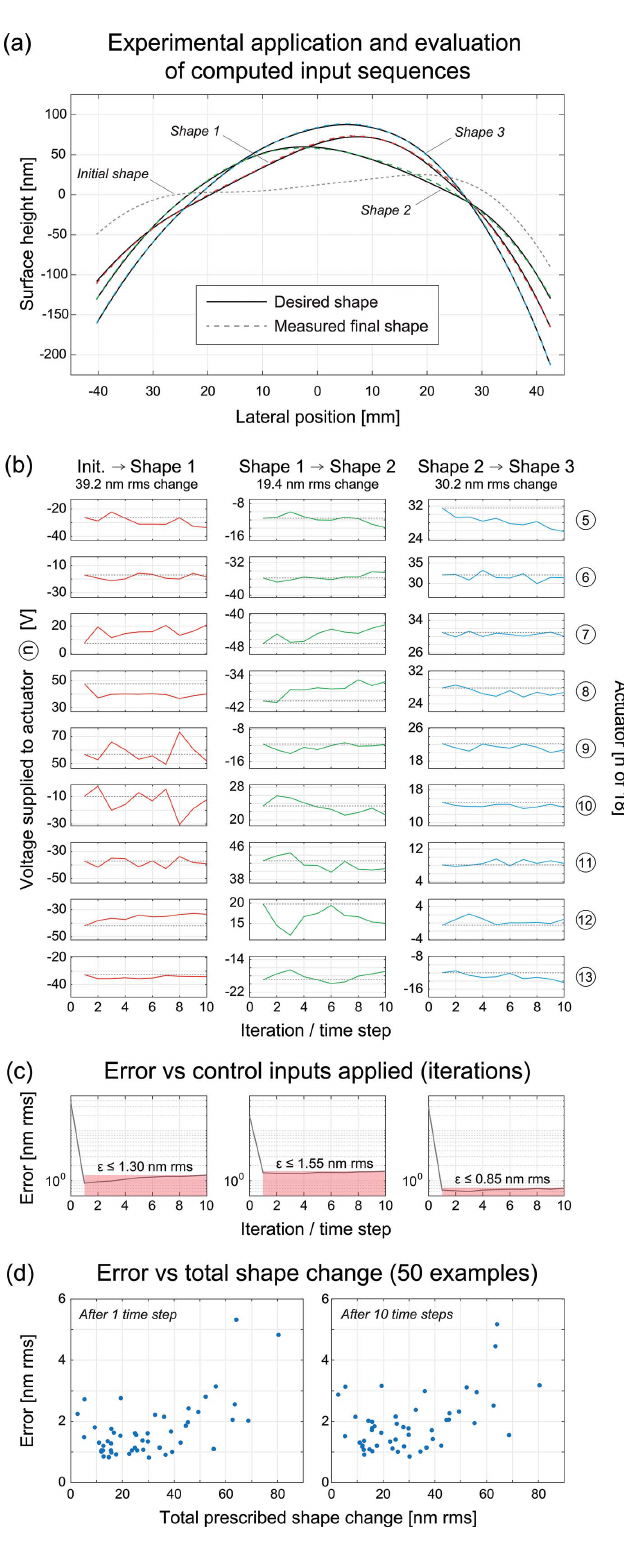
Figure 4 Controlling the mirror to desired surface shapes. ( a ) Measurements of the mirror surface taken over a sequence of three prescribed shapes. ( b ) Voltages applied to actuators over ten solved time steps for the three shape transitions. ( c ) Total shape error in nm RMS over ten time steps. ( d ) Aggregate performance of the control algorithm for the full test set of 50 prescribed random